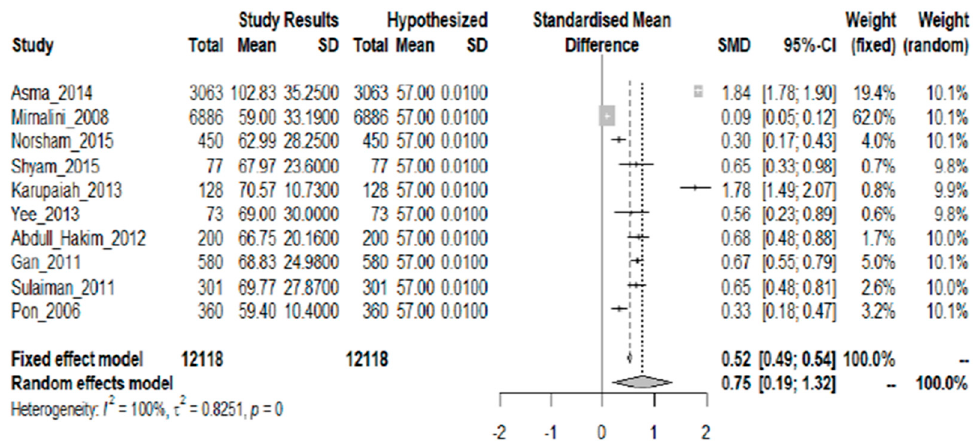
Figure 3. Meta-analysis of studies on protein intake of Malaysian adults. Figure 3. Meta ‐ analysis of studies on protein intake of Malaysian adults.